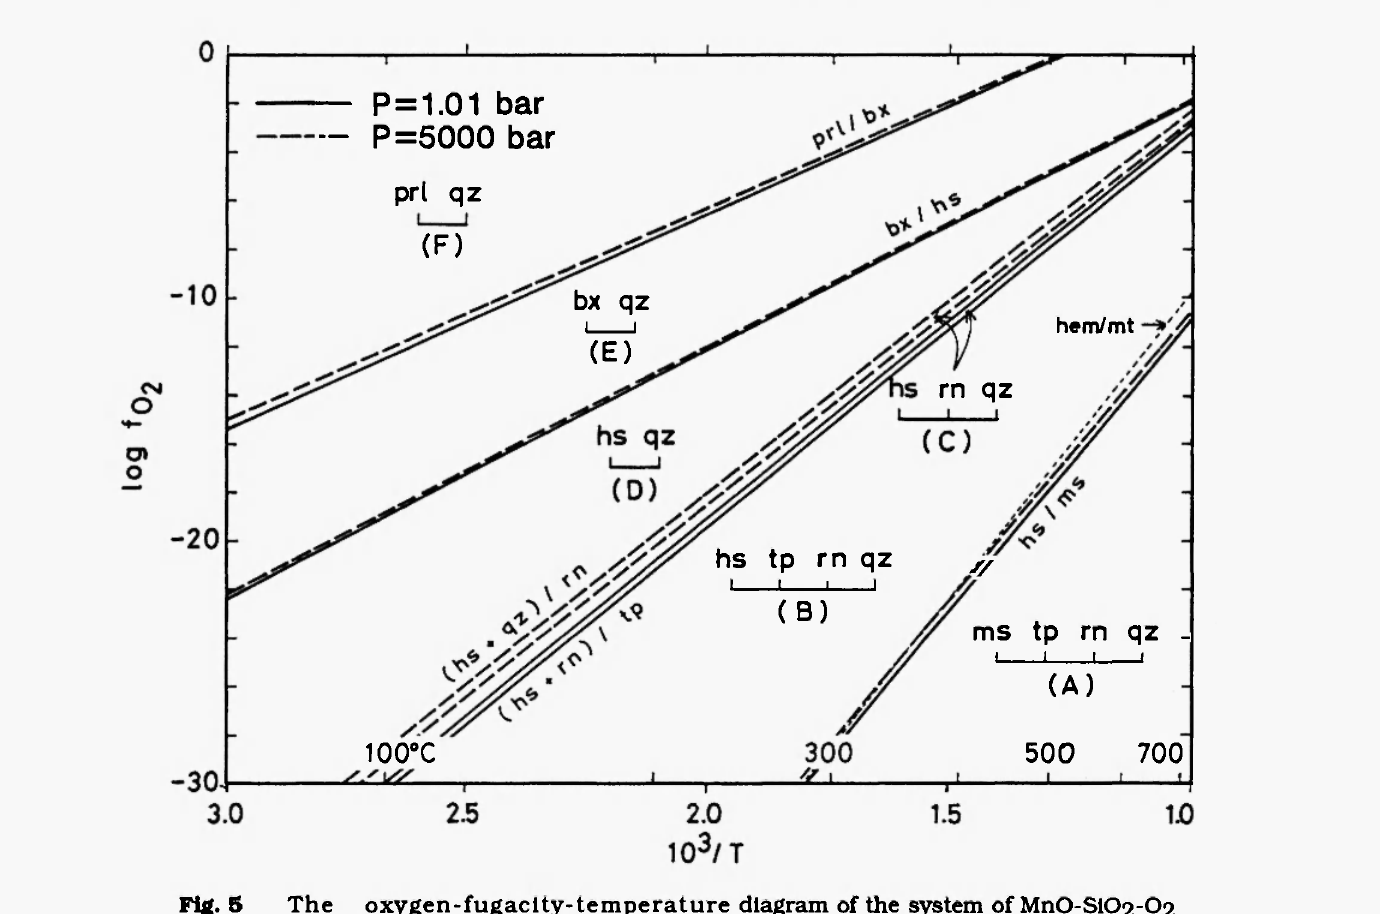
Fig. 5 The oxygen-fugacity-temperature diagram of the system of MnO-SiC>2-02 at 1.01 and 5000 bar. prl:pyrolusite, bxbixbyite, ms:manganosite, qz:quartz, other symbols are identical to those in Flg.